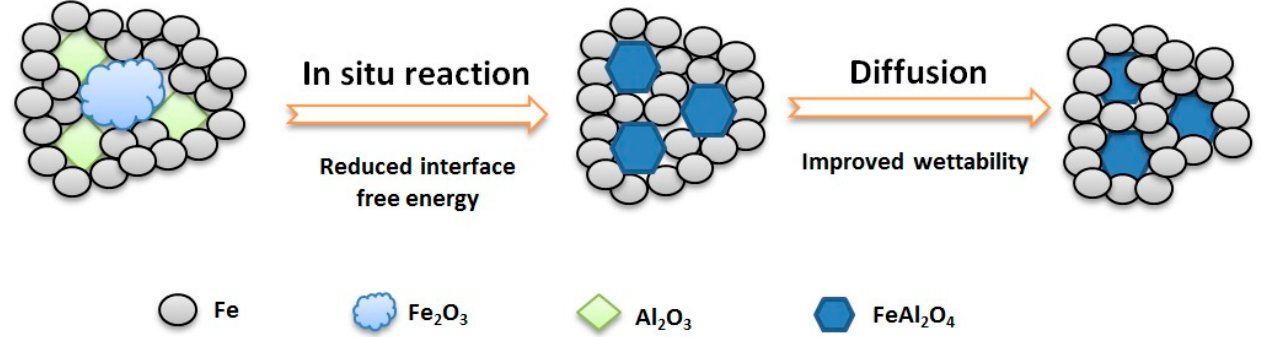
Figure 8. Reaction mechanism of Fe in preparation of Fe/FeAl 2 O 4 cermet by hot press sintering.